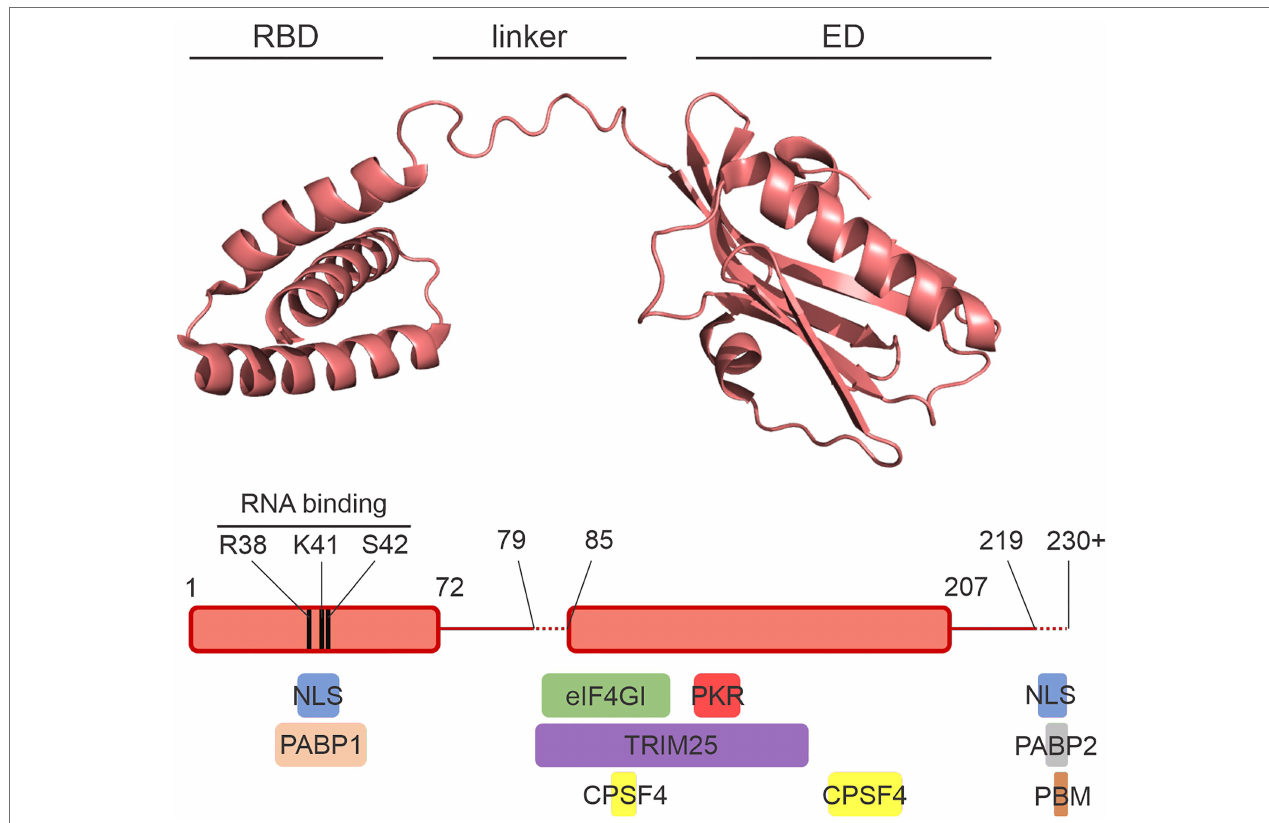
FIGURE 1 | The NS1 protein. A crystal structure of the NS1 protein from A/Vietnam/1196/2004 (H5N1) is shown with the RNA-binding domain (RBD), the effector domain (ED), and the flexible interdomain linker labeled. The diagram below shows the amino acid limits of the domains. The variable lengths of the linker and the structurally disordered C-terminal tail are represented with dashed lines. Colored boxes below the schematic illustrate the approximate regions of NS1 involved in interactions with a select set of host proteins. NLS, nuclear localization sequence; PBM, PDZ-binding motif. Image was prepared with PyMol using the crystal structure from Mitra et al. (2019; PDB ID: